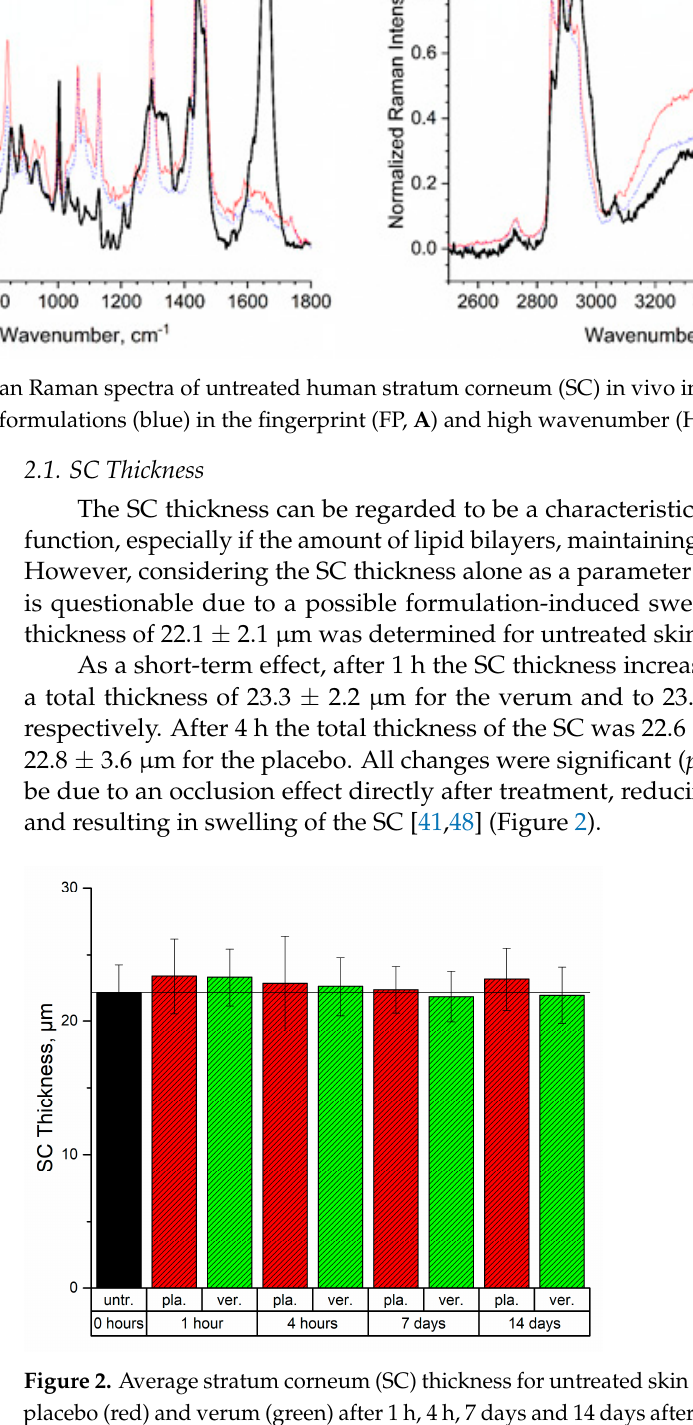
Figure 2. Average stratum corneum (SC) thickness for untreated skin (black) and skin treated with the placebo (red) and verum (green) after 1 h, 4 h, 7 days and 14 days after beginning of the treat- ment. The differences of all treated SC thicknesses compared to untreated SC were strongly signifi- cant ( p < 0.01), no significant differences were found between placebo and verum. The data show mean ± standard